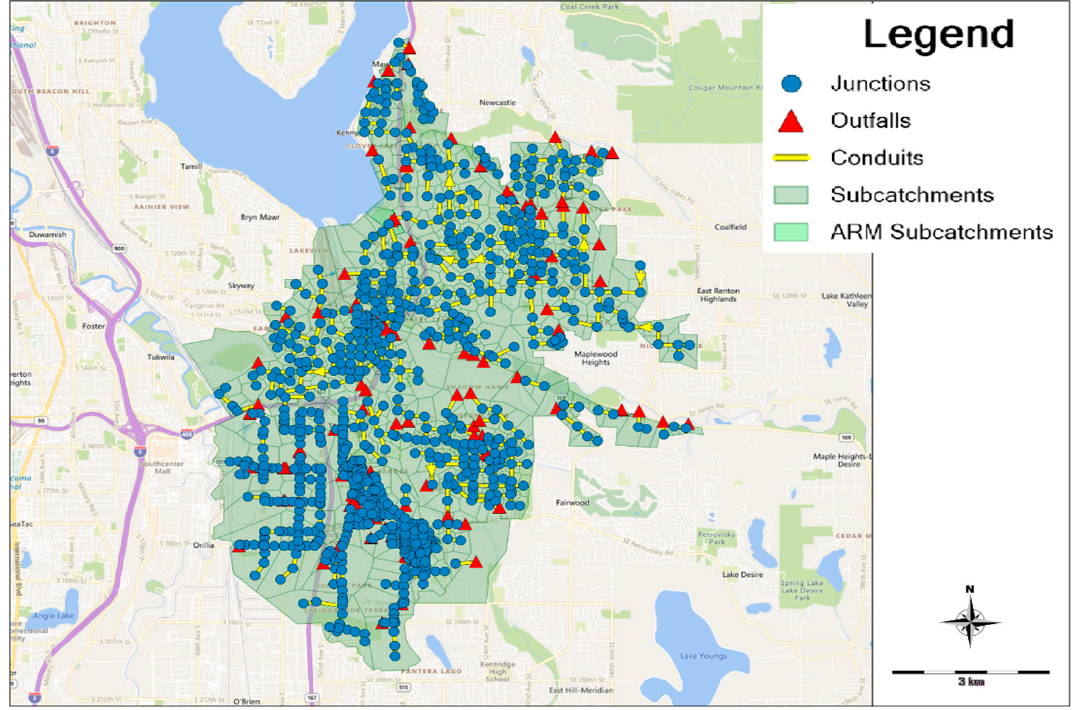
Figure 3 . The sub-catchments and existing stormwater system in our study area. Figure 3. The sub-catchments and existing stormwater system in our study The existing stormwater system, including the LIDs, as well as proposed new LIDs, were incorporated into the model. The infiltration at the LIDs was computed using the Green-Ampt method that uses the initial moisture deficit, 𝜃 , parameter to represent the (cid:2868) initial soil moisture condition before the storm. The initial values of 𝜽 were determined 𝟎 based on the soil types and the depth of the groundwater water table. The King County database (https://kingcounty.gov/services/gis/Maps/imap.aspx, during 20 June 2019 and 7 October 2019 was used to determine the groundwater level, which varies in depth from 0 to 16 feet. Given that the study area has predominately sandy loam soil type, we have considered initial moisture deficit values ranging from 0.35 for sand to 0.25 for sandy loam [66]. 2.4.1. Sensitivity Analysis and Model Calibration The SWMM model outputs can be sensitive to several input data and parameters, making sensitivity analysis an essential step in the model development [67]. Earlier stud- ies found that time to peak and peak flows are significantly affected by the width of the sub-catchment and the soil moisture content [68]. In addition, the percent of impervious- ness areas and slope of the catchment significantly influences flow hydrographs, particu- larly the peak flows. In this study, we considered different hydrological and catchment- related parameters such as percent zero imperv (or percent of the impervious area with no depression storage), percent of imperviousness, curve number, manning coefficient, and channel width for sensitivity analysis. The study area has negligible slopes; hence, the slope is not considered in the sensitivity analysis. Table 1 provides lists of parameters considered in the sensitivity test.